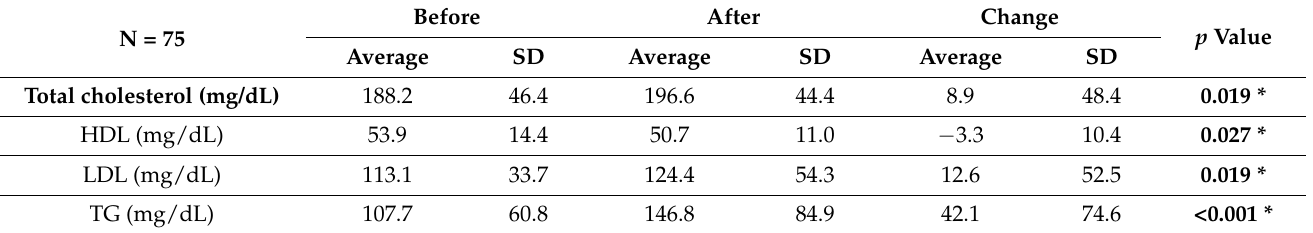
Table 6. Changes in concentration of laboratory parameters before and after chemotherapy.